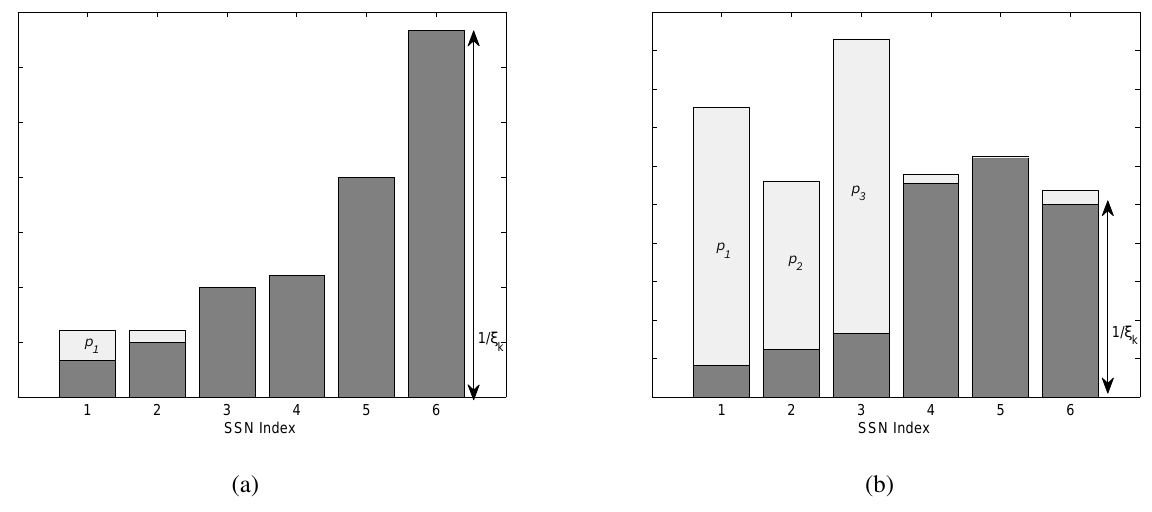
Figure 3. Two example scenarios showing the water-filling allocation for different channel gain and interference gain ratios. ( a ) Scenario 1: When SSN with a good channel to SBS has less interference to the PU. ( b ) Scenario 2: When SSN with a good channel to SBS has more interference to the